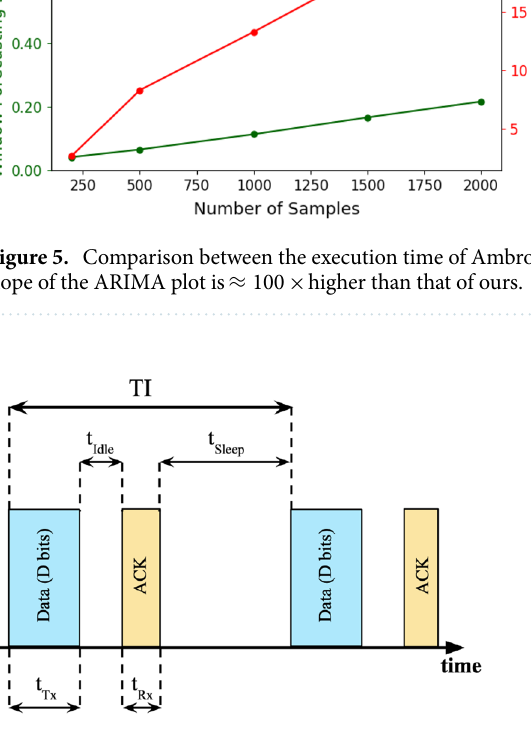
Figure 6. States of the sensor node during a Transmission Interval